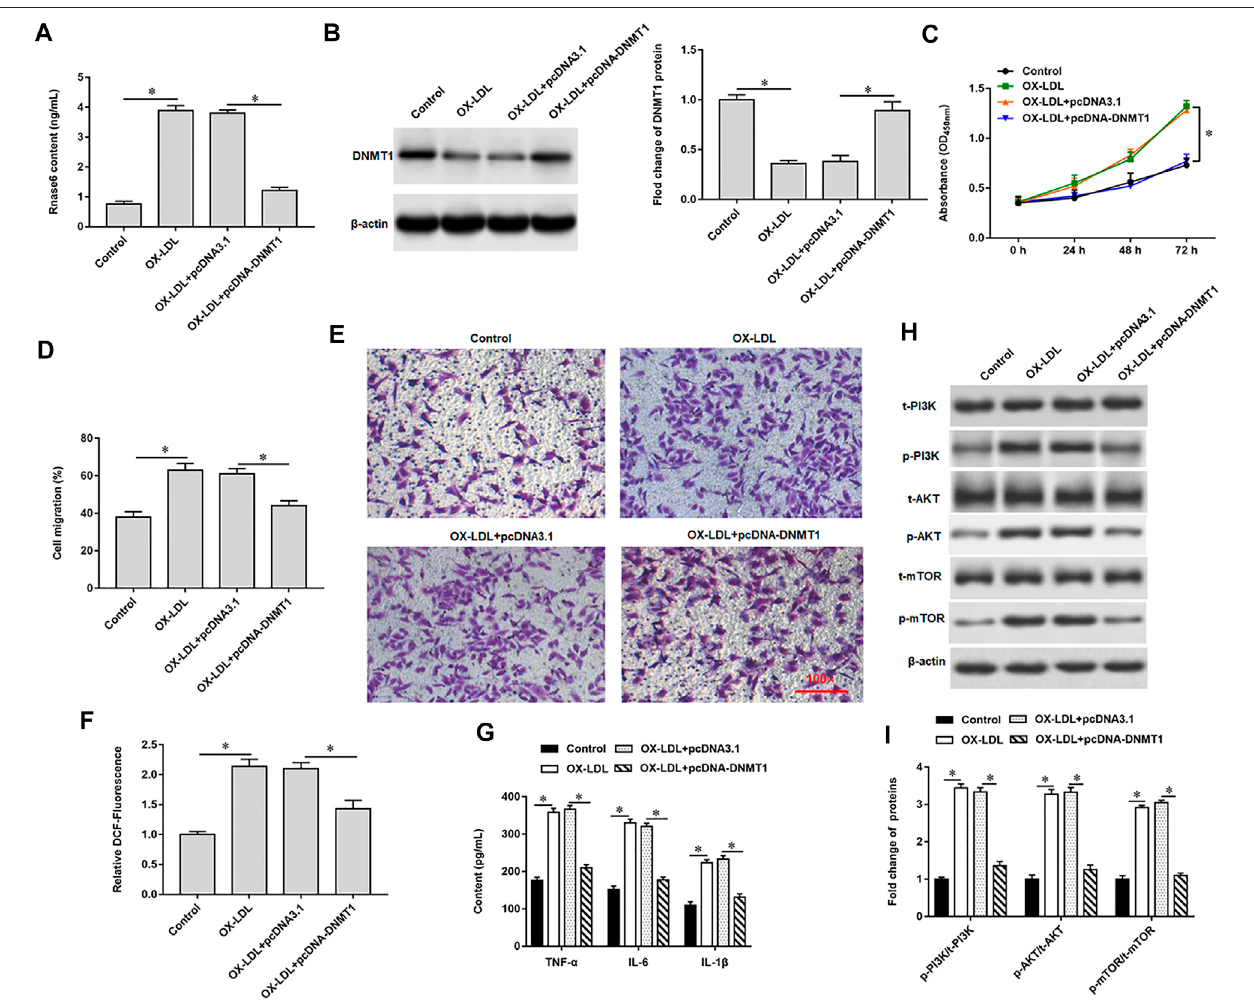
FIGURE 4 | Promoting Rnase6 promoter methylation inhibited OX-LDL-induced proliferation and migration of MOVAS cells. MOVAS cells were induced with OX- LDL for 48 h, and pcDNA3.1 or pcDNA-DNMT1 (2.0 μ g/ml) were transfected in the cells, respectively. (A) . ELISA was used to detected the expression of Rnase6. (B) . Western blotting was used to detect DNMT1 protein expression. (C) . Cell proliferation was analyzed by CCK-8 assay. (D,E) . Trans -well assay was used to measure the cell migration. (F) . ELISA was used to detect the content of ROS. (G) . Relative secretion levels of TNF- α , IL-6 and IL-1 β were analyzed by ELISA kits. (H,I) . Fold change of signaling pathway-related proteins in cells were analyzed by Western blotting. β -actin was used as the loading control. N (cid:2) 6, * p < 0.01.